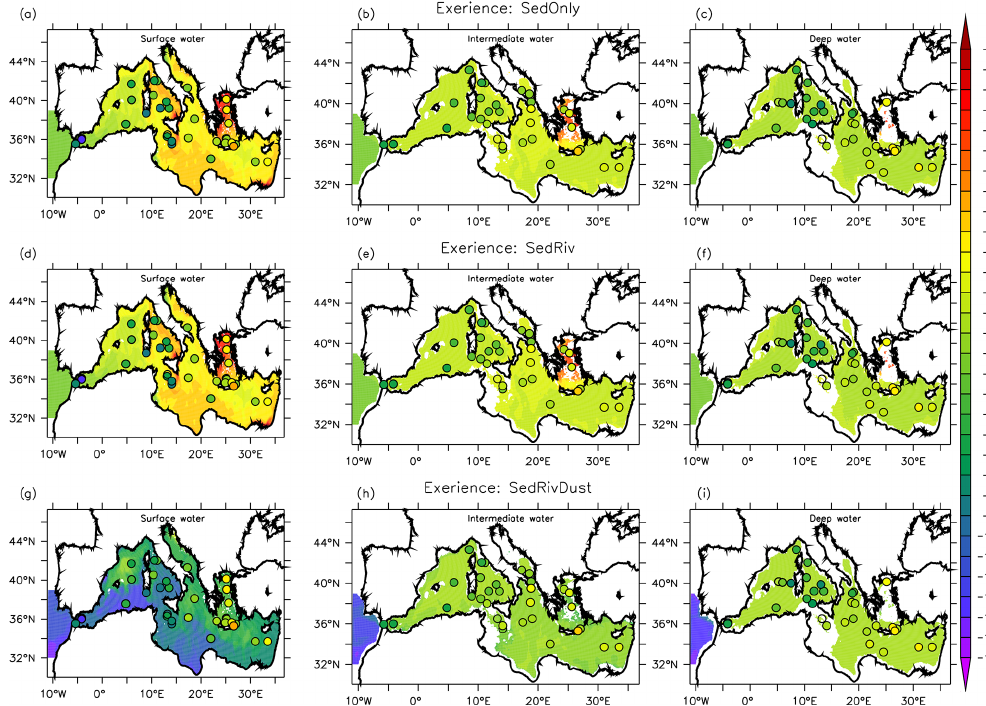
Figure 6. Same as Fig. 3 but for ε Nd (in ε Nd unit).